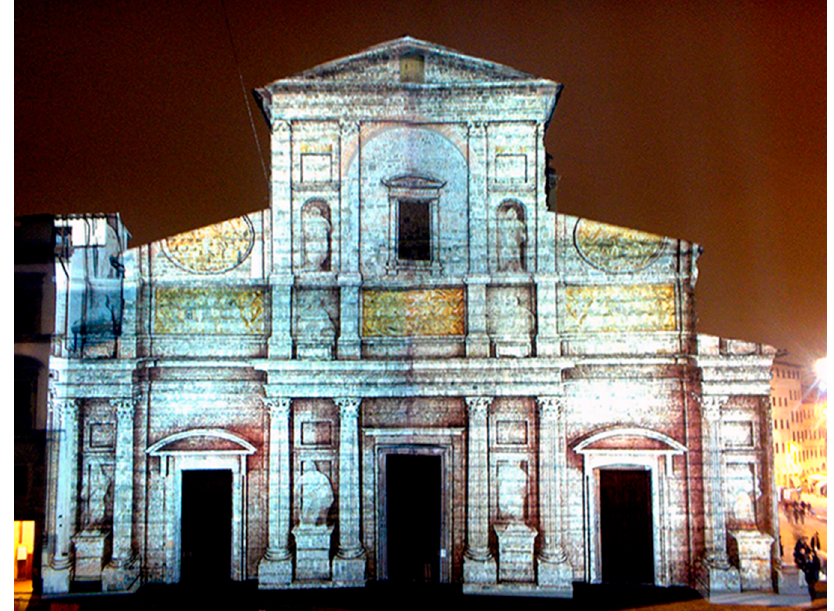
Figure 4. The original project of Michelangelo Buonarroti, overlapped to the actual rustic in Florence, in 2011. Although perfectly matched with the surface, is possible to note the discrepancy between the realized and the original drawings.